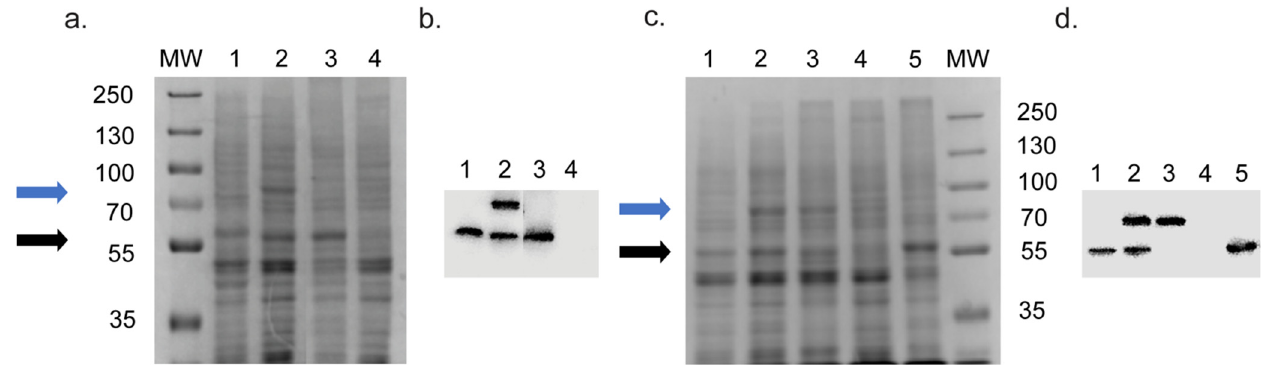
Figure 2. SDS-PAGE and Western blot analysis of CpCYP51-6 × His, CpCYP51-6 × His Y132F and CpCPR-6 × His expression. ( a , c ) Coomassie-stained SDS-PAGE gels of crude membranes (30 µ g) expressing recombinant C. parapsilosis proteins. ( b , d ) Expression of the autologous and recombinant His-tagged proteins detected in Western blots of crude membranes (30 µ g/lane) decorated with mouse anti-6 × His antibody visualised using ECL. ( a , b ) Lanes: 1. CpCYP51-6 × His (Y2719), 2. CpCYP51-6 × His co-expressed with CpCPR-6 × His (Y2721), 3. ScCYP51-6 × His (Y941), 4. Y1857 (AD2 ∆ ). ( c , d ) Lanes: 1. CpCYP51-6 × His Y132F (Y2714), 2. CpCYP51-6 × His Y132F co-expressed with CpCPR-6 × His (Y2716), 3. CpCPR-6 × His (Y2717), 4. Y1857, 5. ScCYP51-6 × His (Y941). Strain genotypes are given in Table 1 and Table S1 (Supplementary Material). MW: 5 µ L protein molecular weight markers (PageRuler Plus Prestained Protein Ladder, Thermo Scientific), molecular weights in